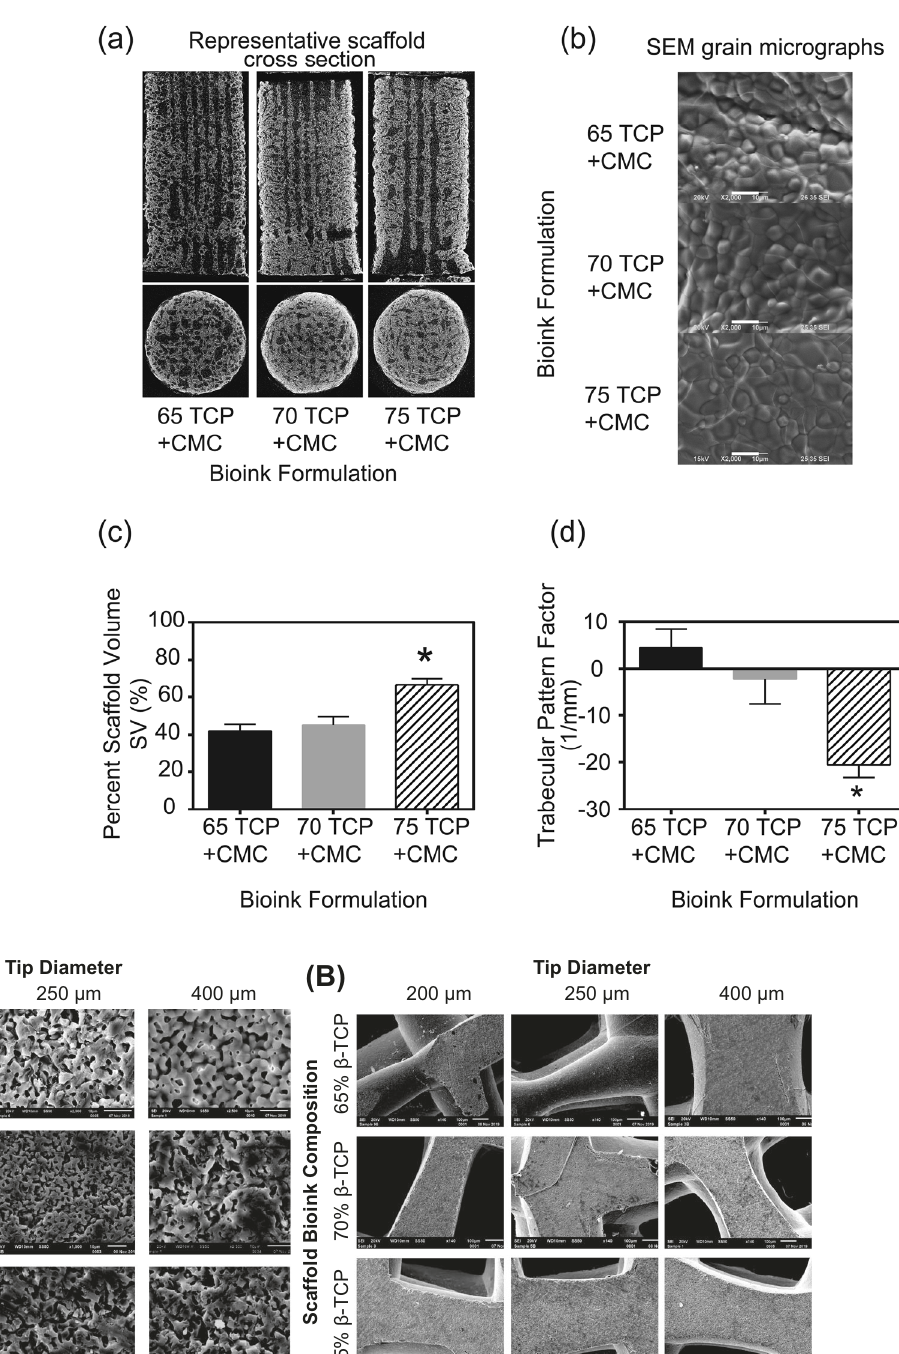
Fig. 2 Scanning electron micrographs of scaffolds of three different printed strut thicknesses composed of the three bioink formulations, tested after sintering. a High-magni fi cation (×2500) micrographs of the 3D-printed scaffolds structures. The internal microporosity within